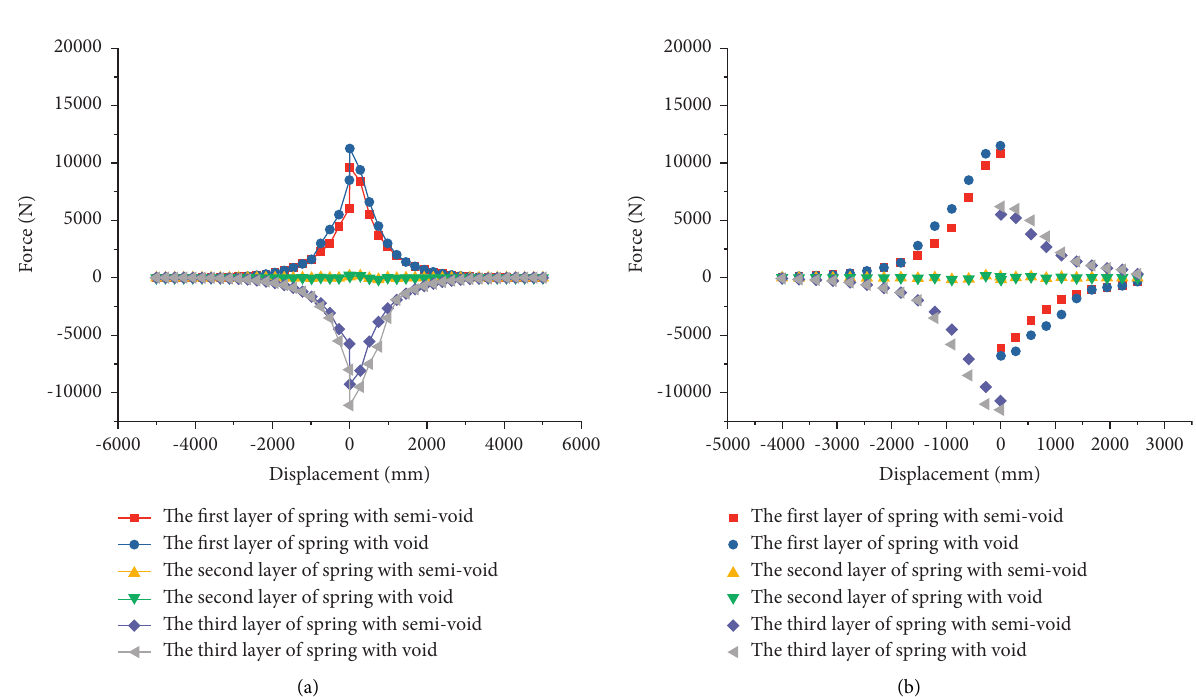
Figure 15: (a) Force analysis of three-layer spring in driving direction. (b) Force analysis of three layer spring in cross-sectional direction.